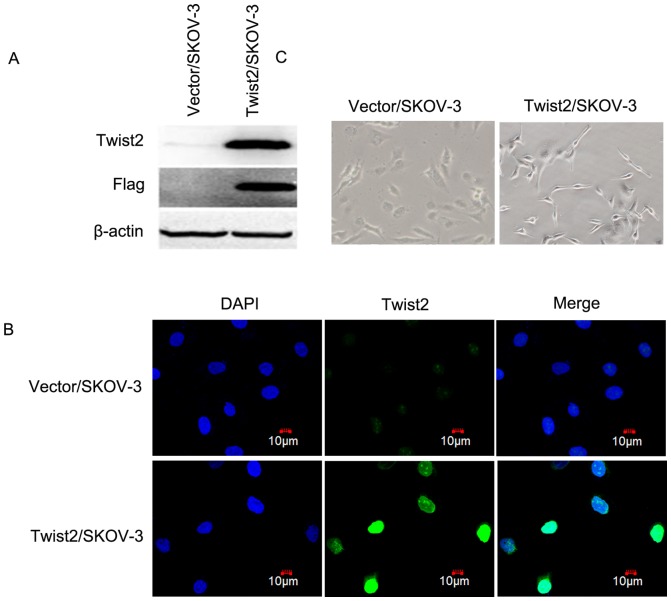
Generation of Twist2-overexpression stable ovarian cancer cells and cell morphological observation.
A. Ectopic expression of the Flag-taggedTwist2 in SKOV-3 (Twist2/SKOV-3) ovarian cancer cells were verified by Western blot. Twist2/SKOV-3 cells expressed both Twist2 and flag-tag compared with vector control cells. B. Twist2 staining was observed using the laser scanning confocal microscopy (Olympus) in SKOV-3 cells. Nuclei were counterstained with DAPI (in blue). Immunofluorescent staining of Twist2 in Twist2/SKOV-3 cells showing cells with Twist2 (in green) in cell nuclei compared with the Vector control SKOV-3 cells. The cells were from the stably transfected samples. C. Cell morphological shapes were observed using phase microscopy (Olympus). Twist2/SKOV-3 cells took on the fibroblast-like morphological shape, while the Vector/SKOV-3 control cells appeared epithelial cell shape.